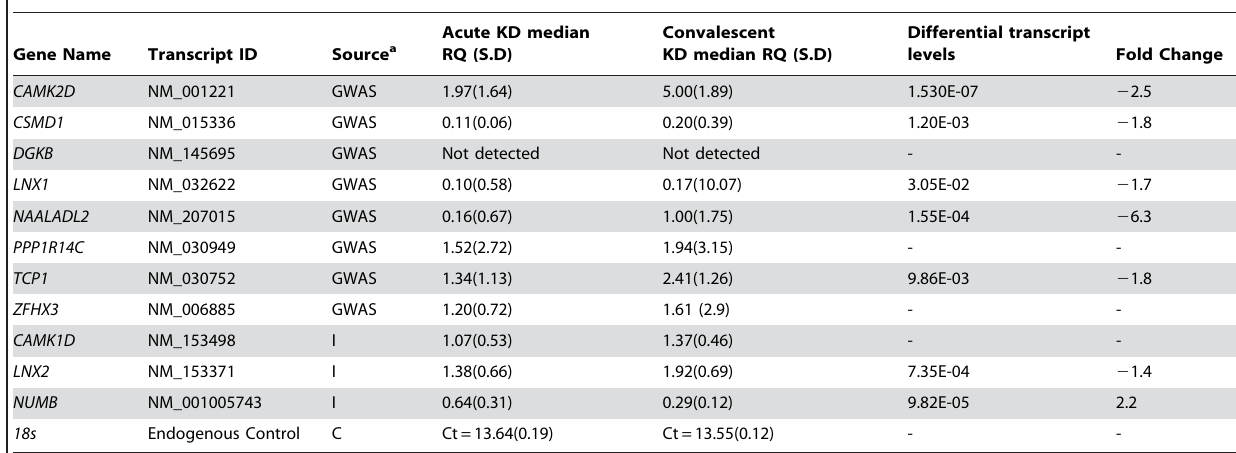
Table 4. Differential Gene Transcript Levels in Acute versus Convalescent